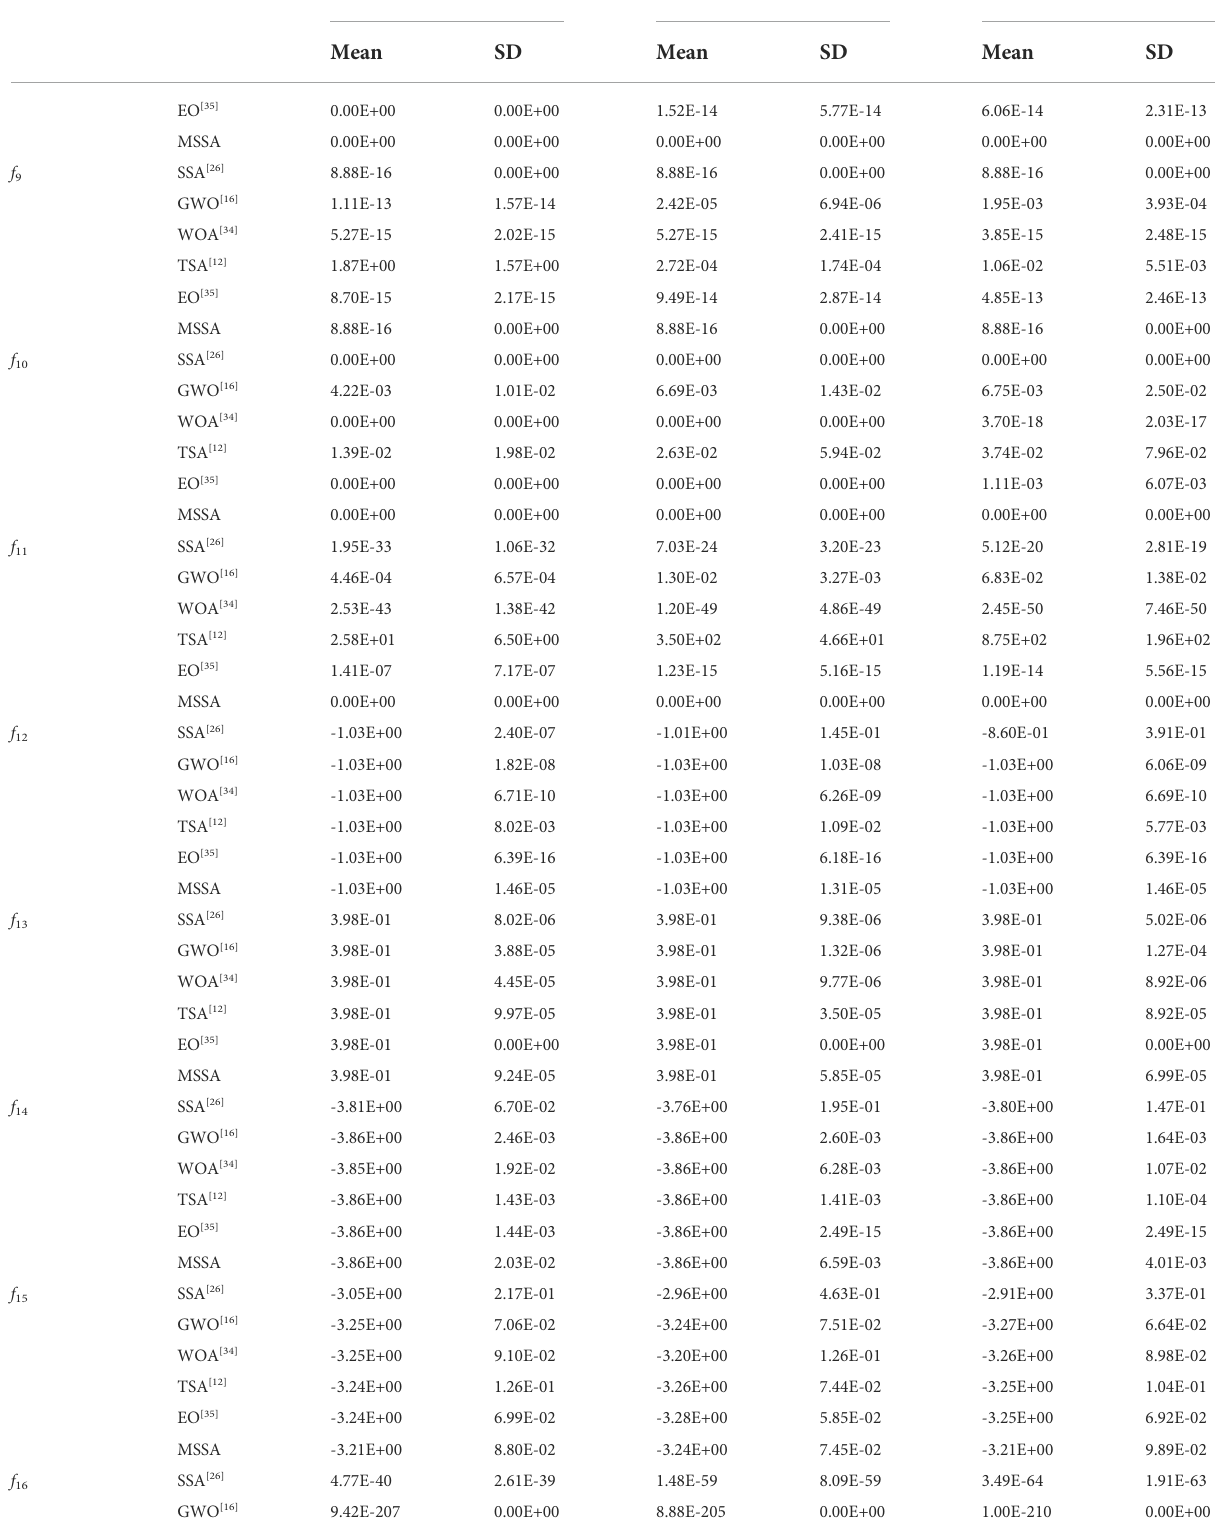
TABLE 3 ( Continued ) Comparison with the results of fi ve metaheuristic algorithms. Fun